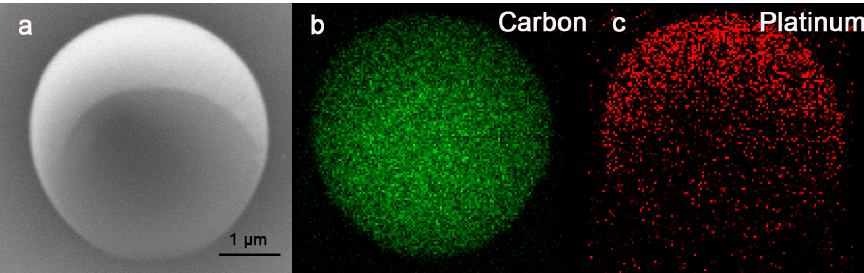
Figure 2. SEM photos of ( a ) magnetic polystyrene (PS) micro-particle, element mapping of ( b ) Carbon and ( c ) Platinum.